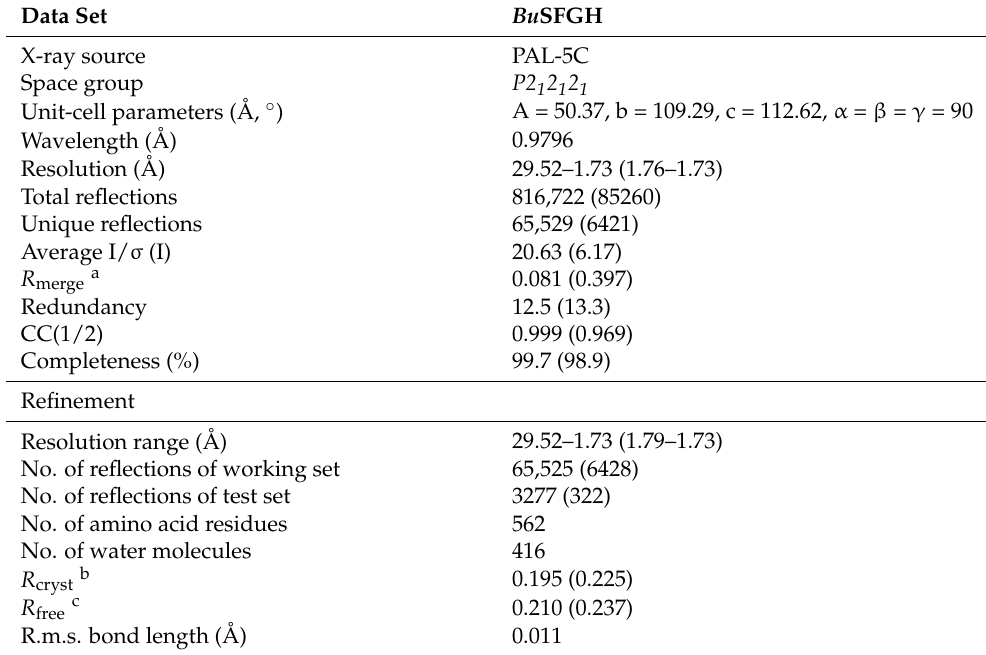
Table 1. X-ray diffraction data collection and refinement